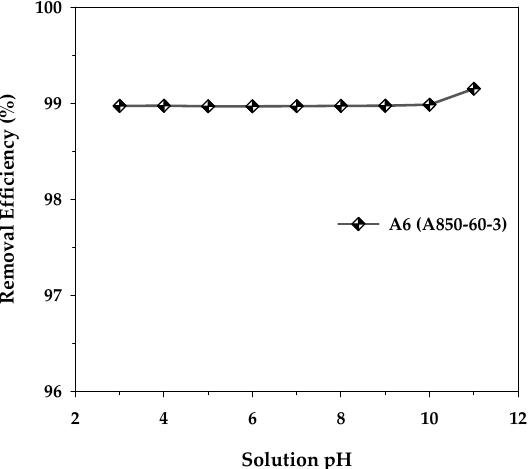
Figure 10. Effect of the initial solution pH on the removal efficiency of MB by the mesoporous- activated carbon (A6), with C 0 = 400 mg/L, carbon dosage = 0.8 g/L, and T = 35 °C.